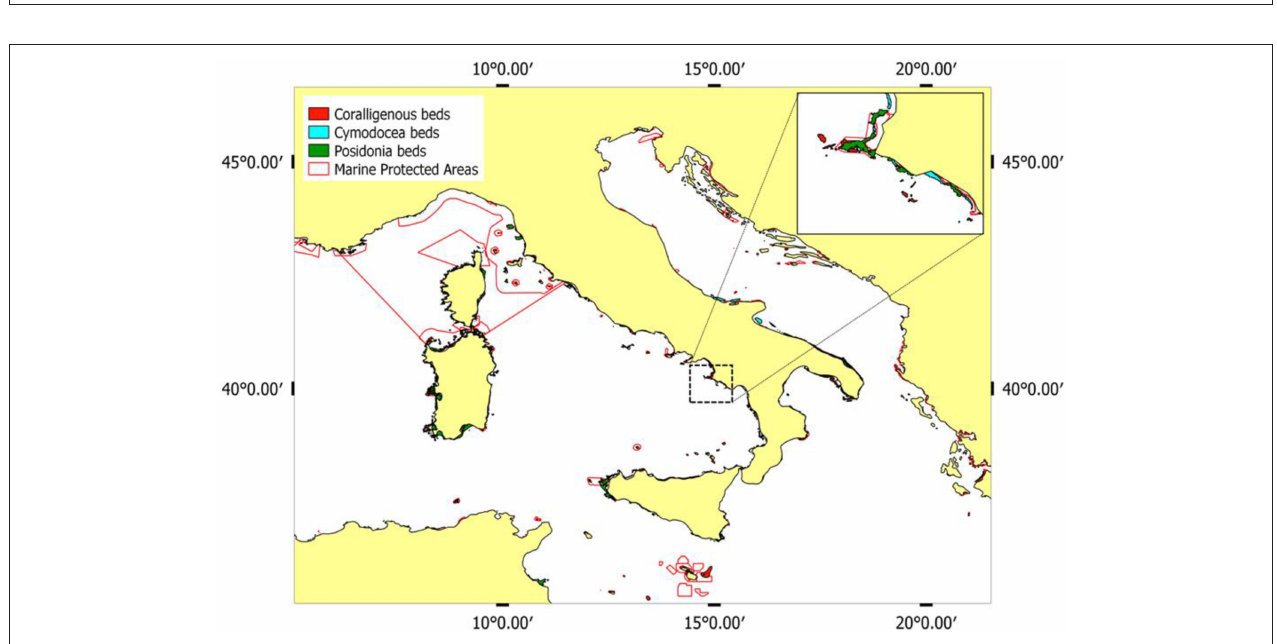
FIGURE 2 | Meteo-climatic stations ( n = 164). The analysis grid is also shown.